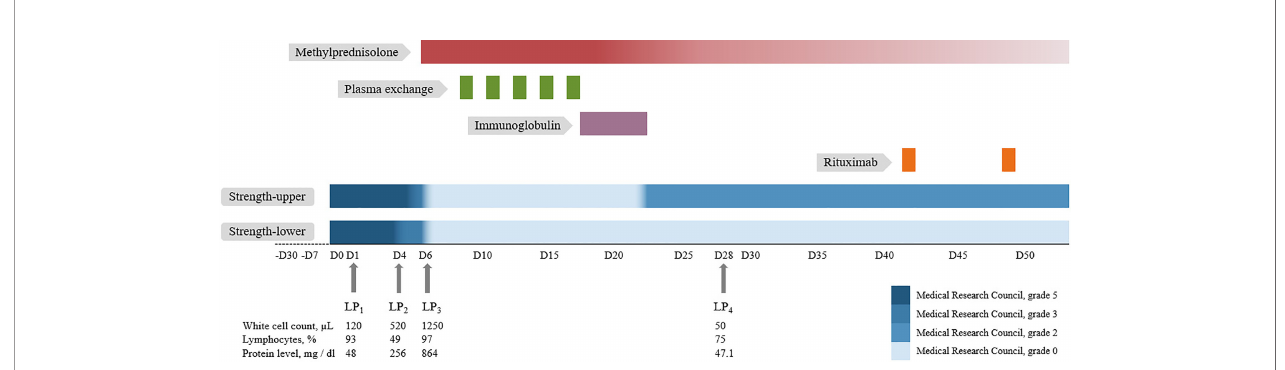
FIGURE 2 | Timeline depicting muscle strength change, immunotherapy, and cerebrospinal fl uid analysis of the patient. For further details, refer to the main text. LP, lumbar